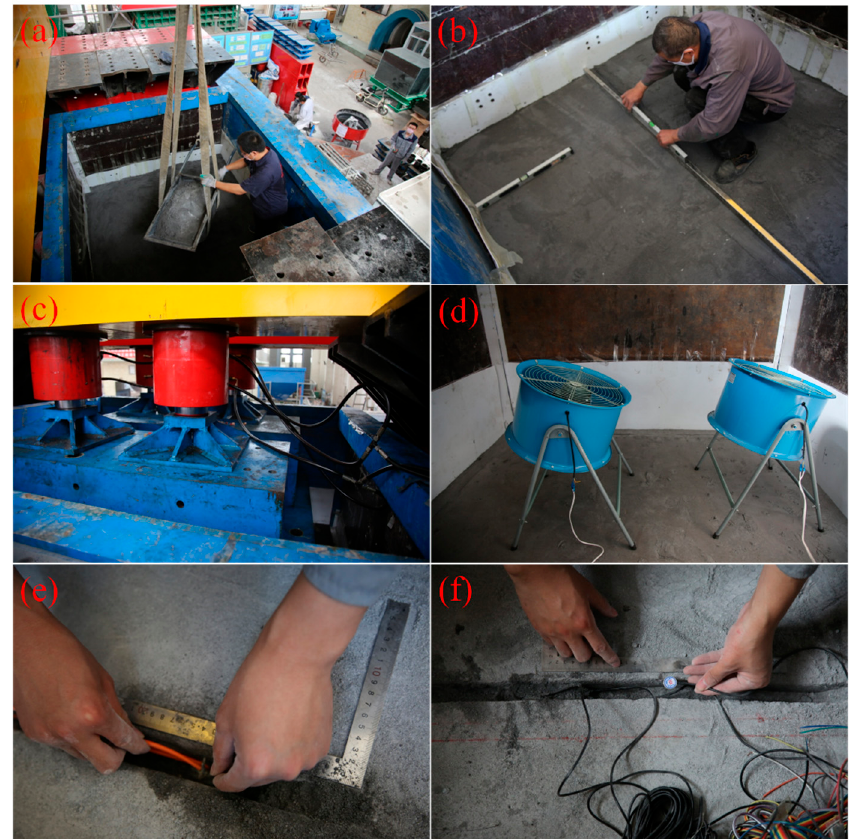
Figure 9. Photos of the construction of the physical model. ( a ) The mixed material is poured evenly into the test system; ( b ) the material is spread evenly; ( c ) the material is compacted by the loading system; ( d ) materials are air-dried with electric fans; ( e ) the optical displacement sensor is embedded; and ( f ) the strain sensors are embedded.